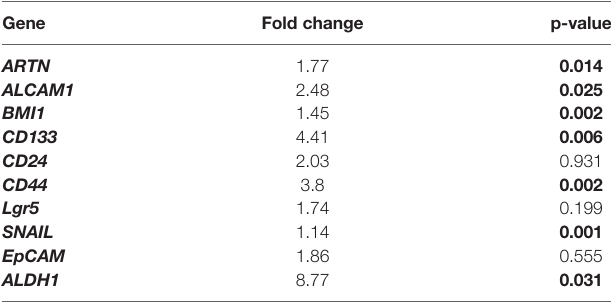
TABLE 4 | Real time-PCR analysis for mRNA expression of colorectal CSC marker genes and the ARTN gene in DLD1 cells. Gene Fold